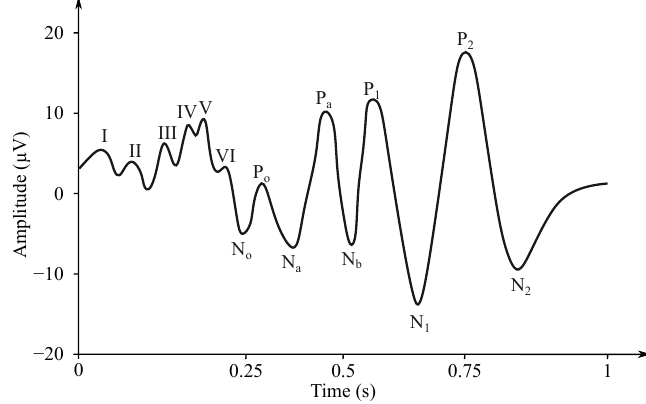
Figure 8. Example of the VEP signal